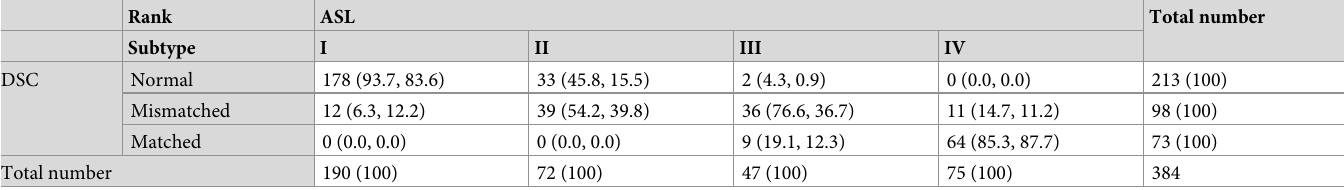
Table 2. Numbers of areas showing perfusion abnormalities in 32 patients with ischemic stroke (with percentages of the proportions of each ASL rank and each DSC subtype within parentheses), as determined by ASL imaging and DSC perfusion imaging. ASL rank I refers to no HVS or PPD, II refers to the presence of HVS without PPD, III refers to the presence of HVS and PPD, and IV refers to the presence of PPD without HVS (r = 0.82, p = 0.01 by Spearman’s rank test).